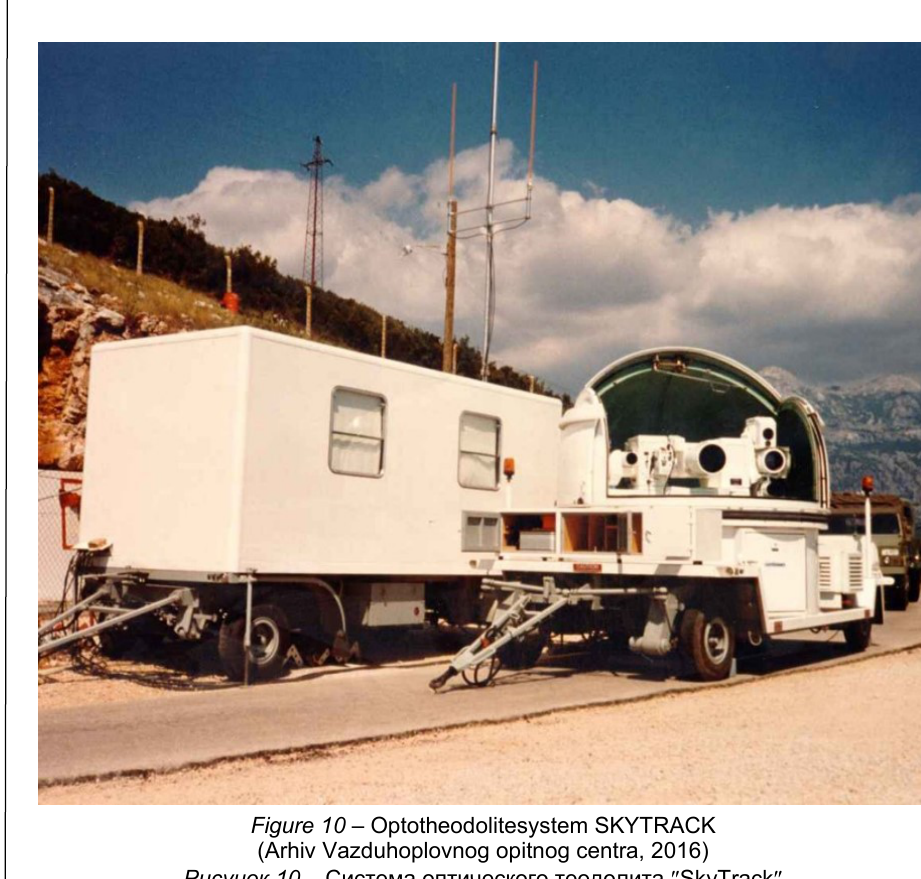
Figure 10 – Optotheodolitesystem SKYTRACK (Arhiv Vazduhoplovnog opitnog centra, 2016) Рисунок 10 – Система оптического теодолита  SkyTrack  (Arhiv Vazduhoplovnog opitnog centra, 2016) Слика 10 – Оптотеодолитски систем „SKYTRACK” (Arhiv Vazduhoplovnog opitnog centra,